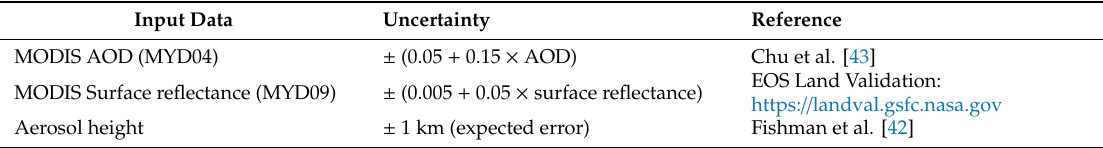
Figure 11. Percent difference in PBL SO 2 AMF calculated with various AOD, surface reflectance, and APH values compared with a ‘true’ AMF that is calculated for AOD = 0.27, surface reflectance = 0.05, and APH = 0 and 1 km for ( a ) SZA = 20° and ( b ) SZA = 60° (VZA = 40°; RAA = 0°; O 3 VCD = 275 DU; wavelength = 318 nm; aerosol type = sulfate). Table 2. AOD and surface reflectance